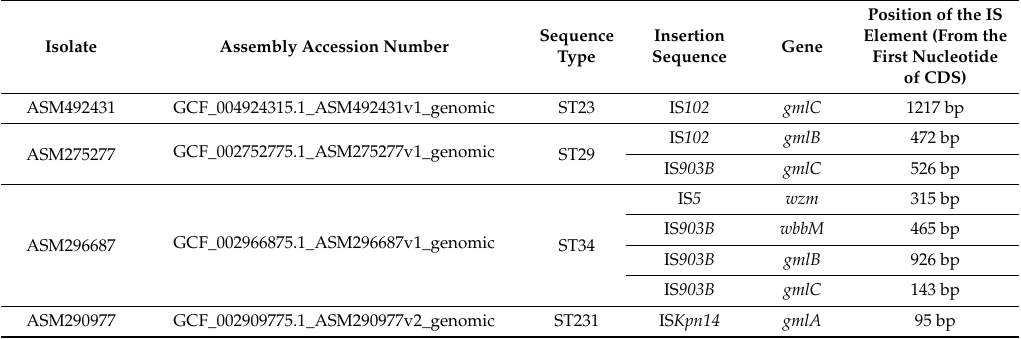
Table 3. Sequence type and location of IS elements in the rfb clusters of K. pneumoniae isolates selected on the basis of Kaptive-based O1v2 predictions a